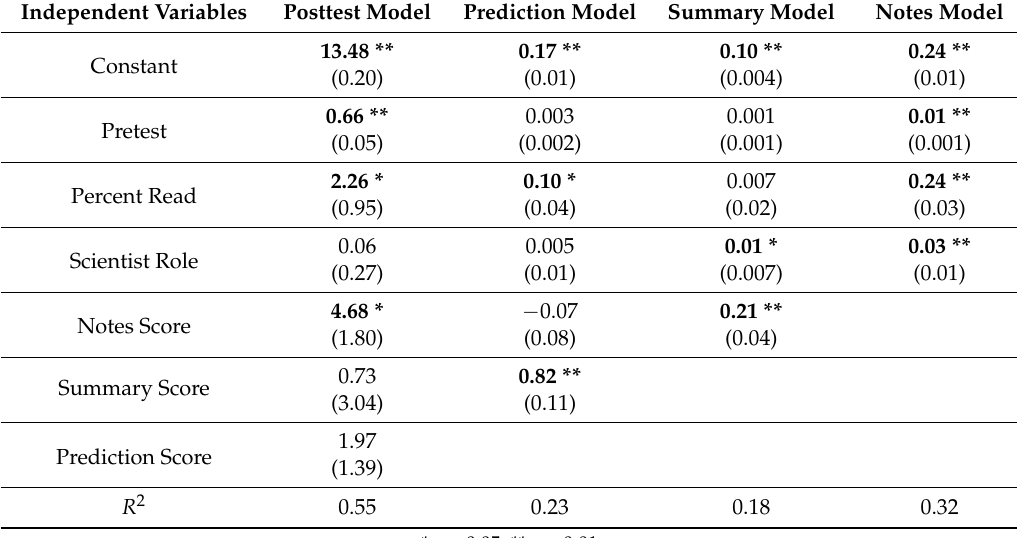
Table 3. Regression results for four models examining the direct and indirect influence of student role on the quality of responses to academic prompts and posttest outcomes. The reported coefficients are unstandardized with standard errors in parentheses. Statistically significant coefficients are presented in